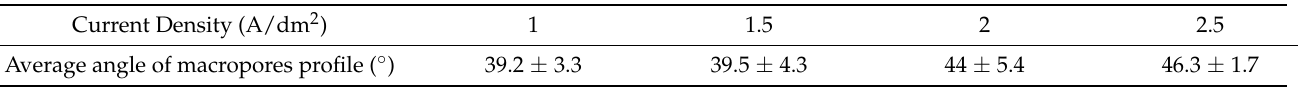
Table 3. Cross-section angles of bell-mouthed macropores in a deposition at different current densities. Current Density (A/dm 2